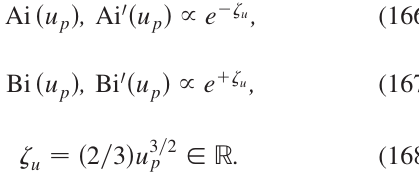
FIG. 13. The longitudinal field of the damped mode (solid line) and the oscillatory mode (dashed line) for a Gaussian bunch. The parameters are the same as Fig.